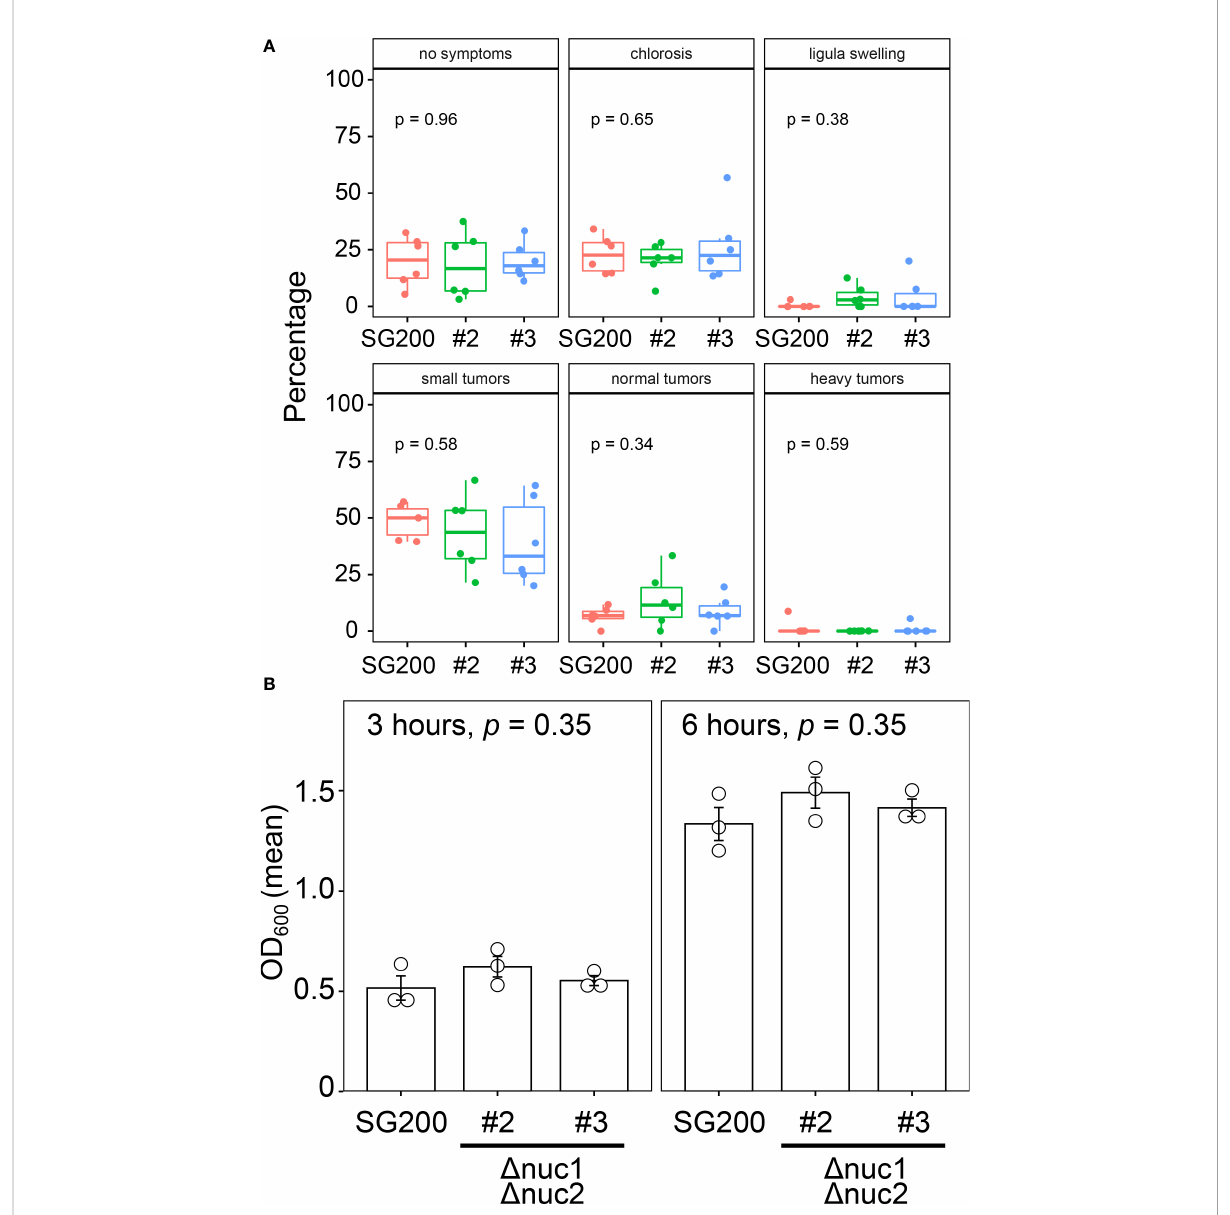
FIGURE 4 Virulence and growth ability of SG200 D nuc1 D nuc2 mutants in U. maydis . (A) Pathogenicity assay of the double deletion mutants of nuc1 and nuc2 in U. maydis . Disease symptoms were quanti fi ed based on six biological replicates. The percentage of plants placed in a certain disease category is calculated in each replicate and represented as box plots. One-way ANOVA test was applied to detect signi fi cant difference of disease symptom among SG200 and SG200 D nuc1 D nuc2 mutants. p -value is indicated in each disease category. (B) Growth rate of SG200 D nuc1 D nuc2 mutants in U. maydis . Suspension of sporidia cells (OD 600 = 0.2) were cultured in YEPSL liquid medium. Optical density (OD 600 ) was measured after 3 hours and 6 hours cultivation, respectively. Three biological replicates (depicted as open circles) were prepared to determine the mean of optical density and standard errors. One-way ANOVA test was used to apply statistical analysis and p -values were indicated in respective panels of bar